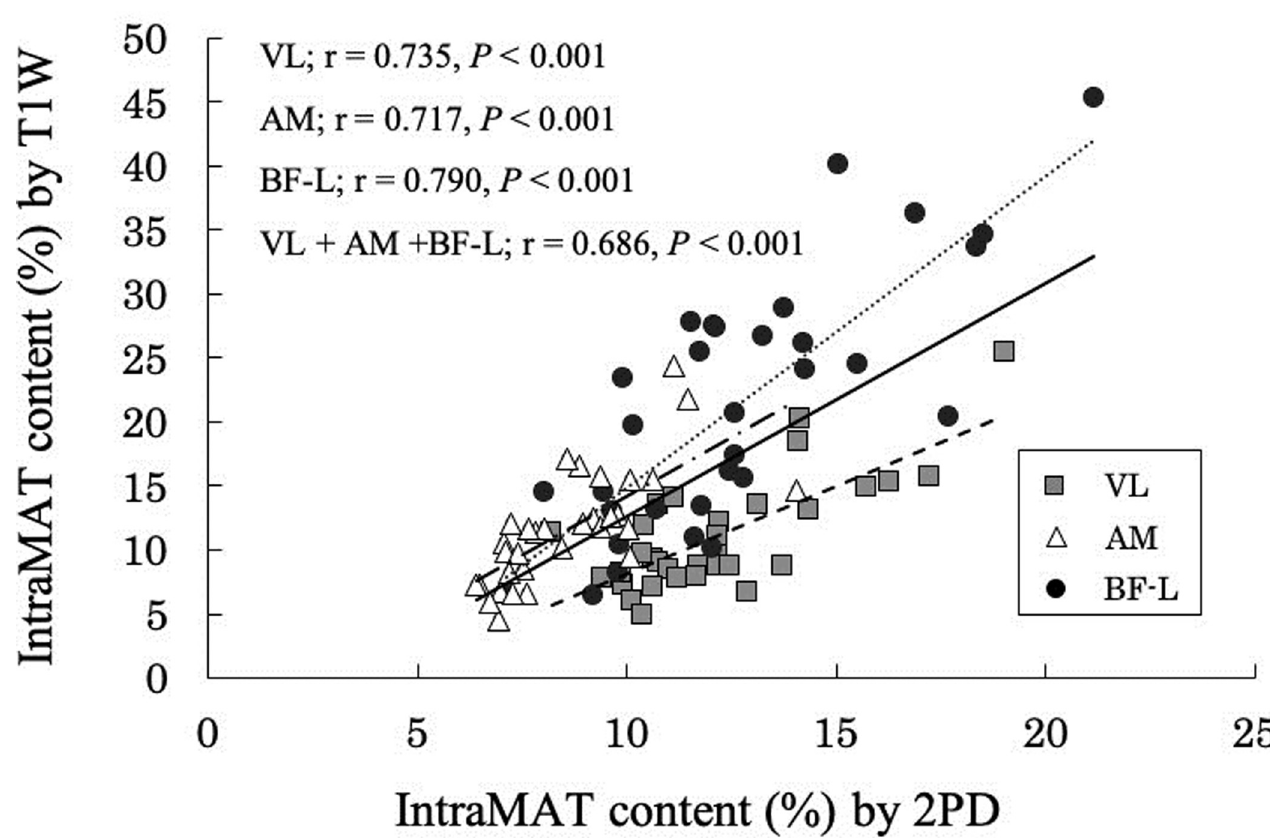
Fig 2. Relationship between the intramuscular adipose tissue content (IntraMAT content; %) using T1-Weighted (T1W) and 2-Point Dixon (2PD) images in the Vastus Lateralis (VL), Adductor Magnus (AM), and the Biceps Femoris-Long head (BF-L).